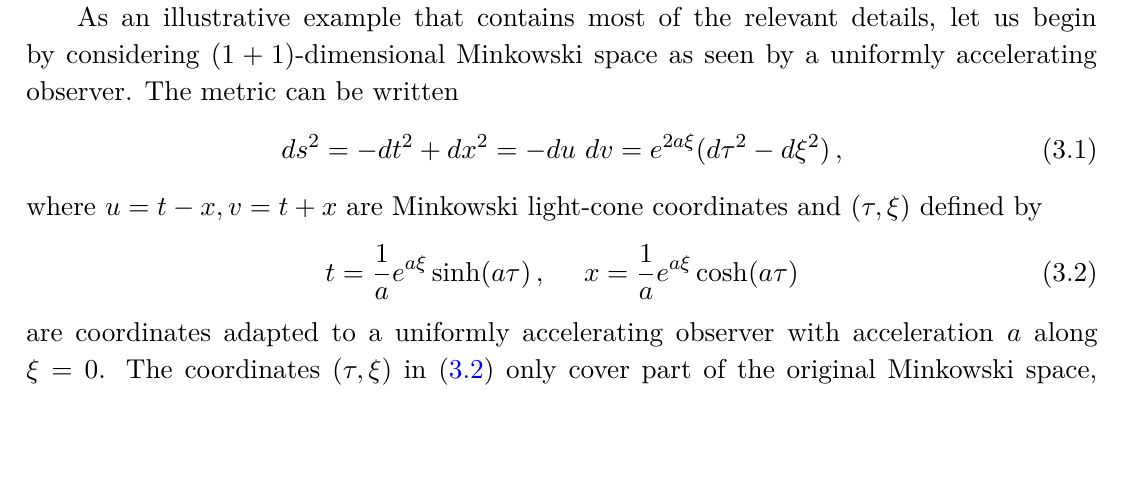
] (2.56). As also th